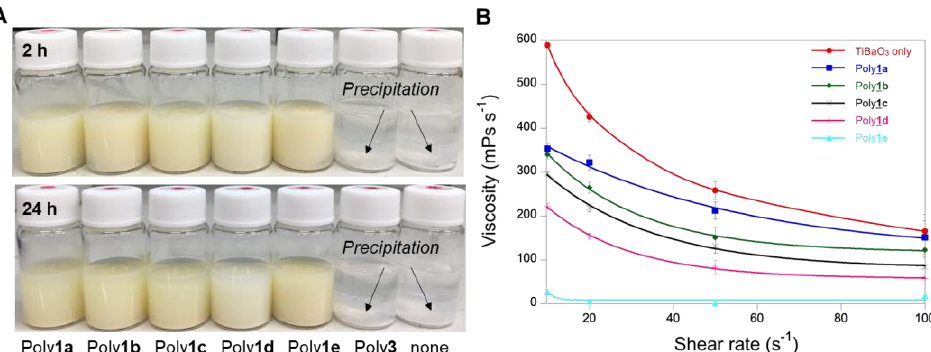
Figure 3. ( A ) Photographs of BaTiO 3 dispersed in a chloroform solution in the presence of Poly 1a – 1e . ( B ) Relationships between the shear rate and the viscosity in dispersions comprising the copolymers, BaTiO 3 , and 1,1,2,2-tetrachloroethane. To further clarify the effect of the monomer position of Poly 1 on the dispersibility of BaTiO 3 at a shear rate of 100 s − 1 , we plotted the viscosity versus D p of the domain of Poly 3 ( n ) and the viscosity versus the composition ratio (mol%) of 1 in the domain of Poly 4 in Poly 1 (Figure 4). To our surprise, the viscosity behavior was completely different from that of the adhesive: the viscosity decreased linearly with D p , whereas it decreased expo- gest that the adhesive moiety 1 should preferably be concentrated at one end of Poly 1 , and a longer Poly 3 domain contributes to better dispersion.